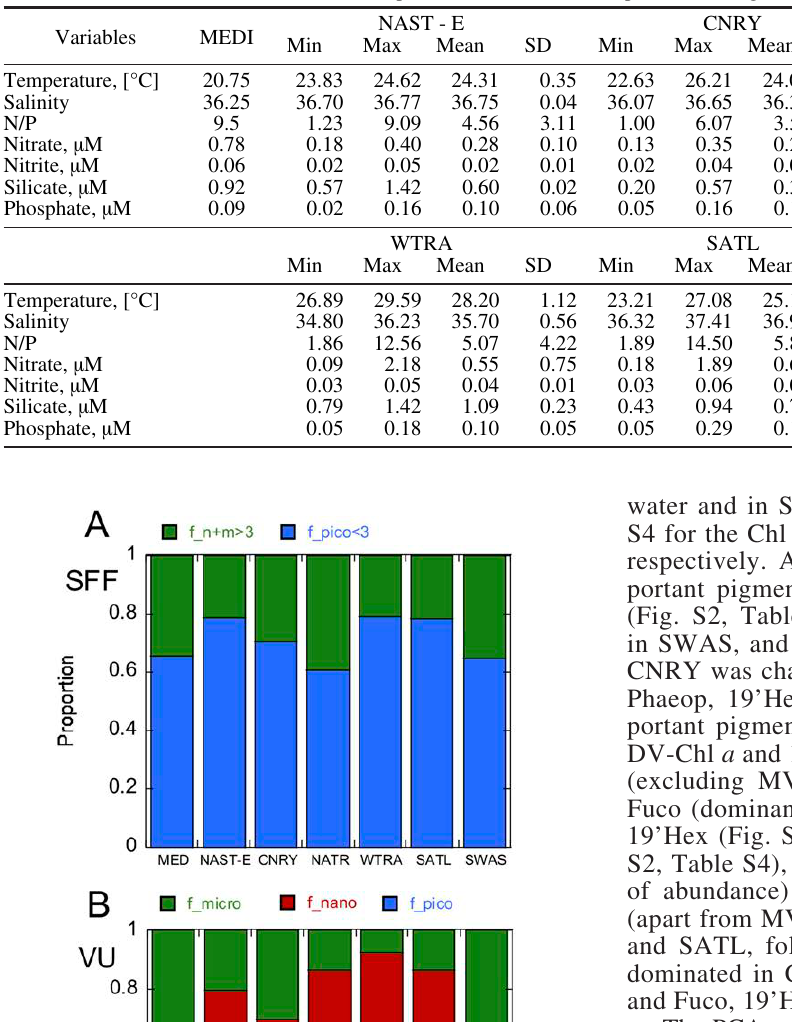
Table 3. – Range (minimum: Min and maximum: Max), mean and standard deviation (SD) of temperature (1 C), salinity, ratio between the sum of nitrite + nitrate and phosphate (P/N) and major nutrients (nitrate, nitrite, silicate and phosphate, µM) for the seven study provinces. For province names, see the explanation in Figure 1.